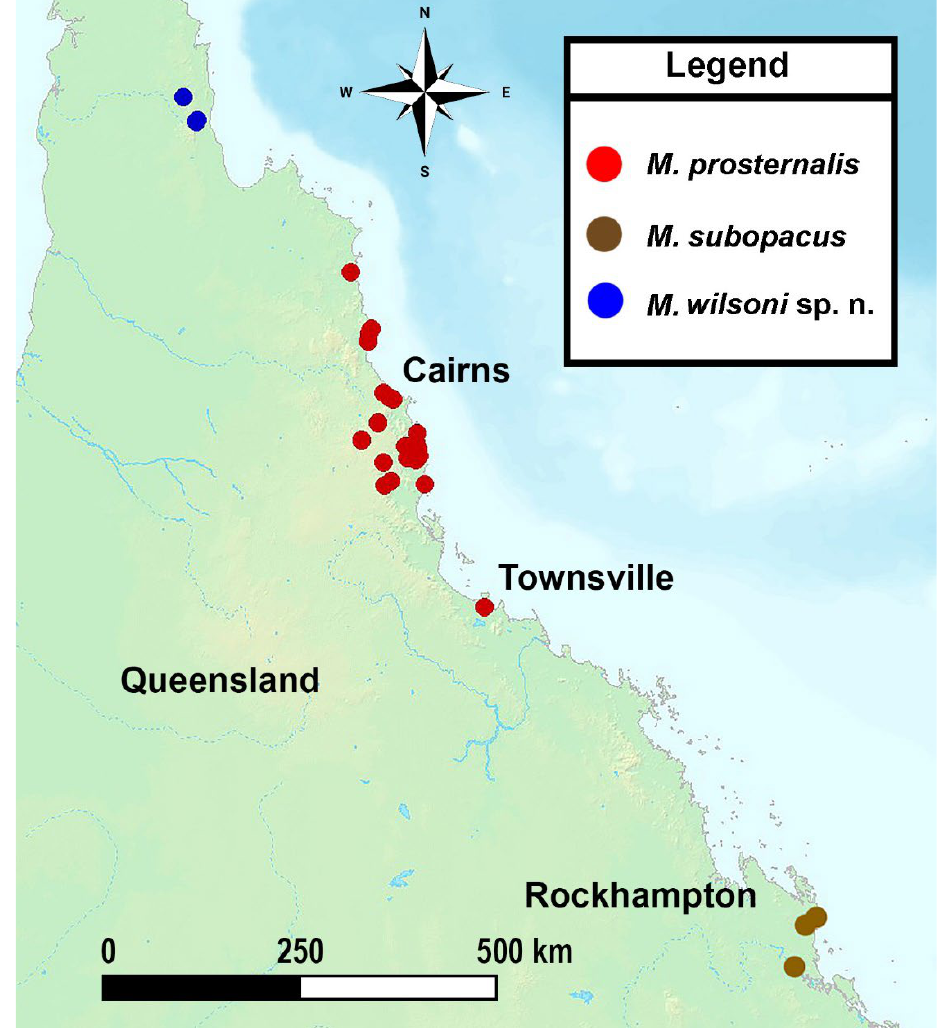
Figure 14. Geographical distribution of Miltotranes in central to northern Queensland in Australia.